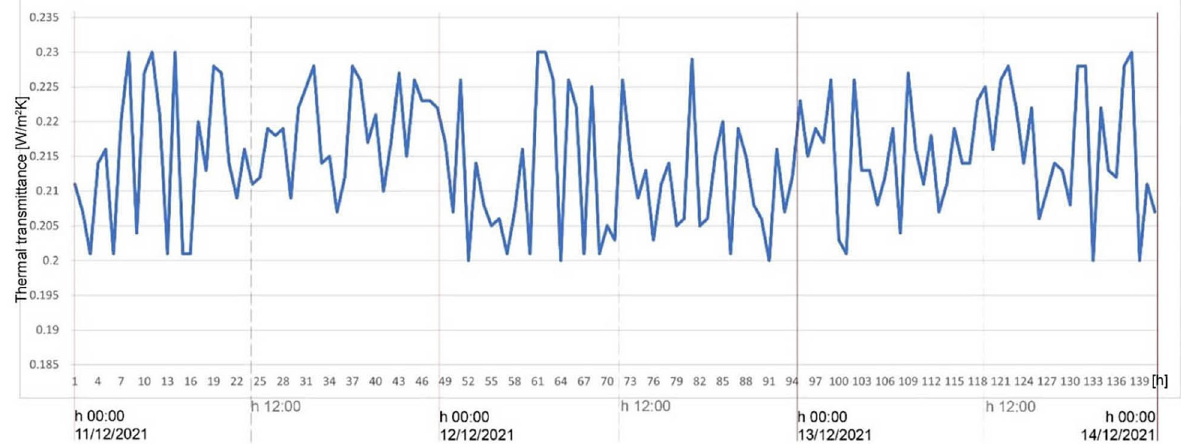
Figure 18. Tuff perimeter wall thermal transmittance diagram as a function of time: post